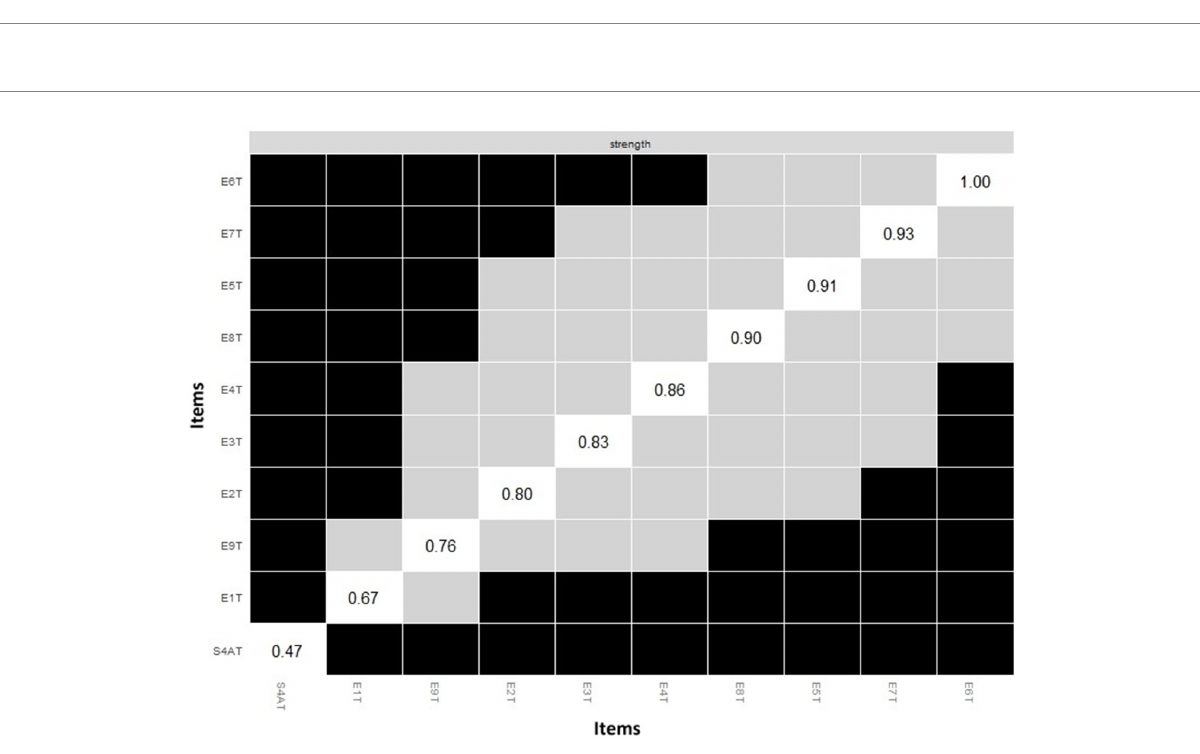
FIGURE 5 Stability of the strength centrality index. The stability of the strength centrality index is shown, where the red line is the correlation between the strength index estimate and the subsamples that would be used from the total sample.